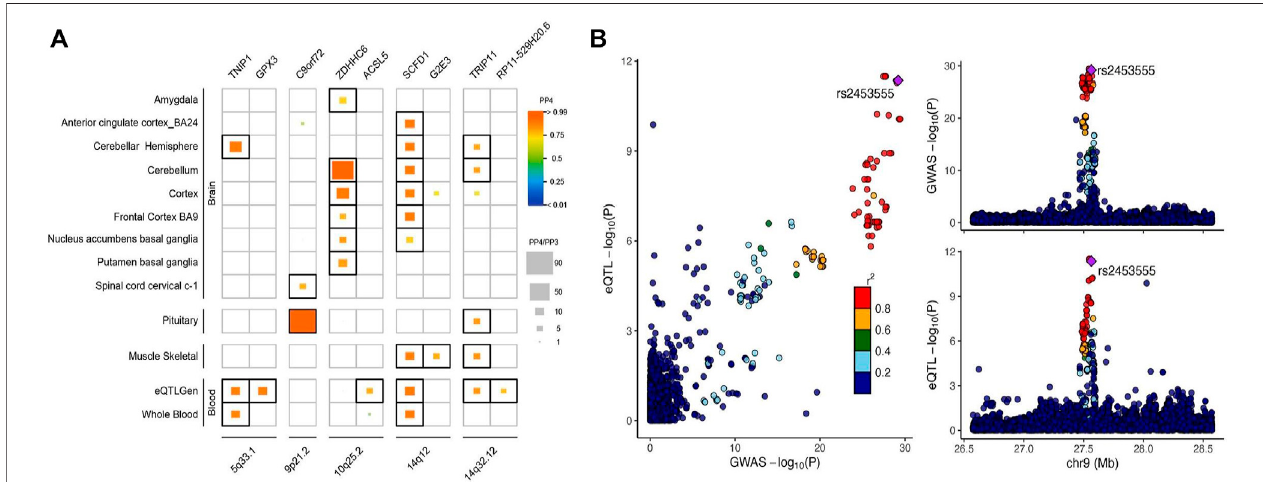
FIGURE 3 | Colocalization of genetic ALS association and eQTL in different tissues. (A) Heatmap of signi fi cant colocalization (PP4 ≥ 0.75, PP3 + PP4 ≥ 0.9, and PP4/PP3 ≥ 3)inatotalof16tissuesanalyzed.Thehorizontalaxisrepresentedgenesunderdifferentcytobands,andtheverticalaxisrepresenteddifferenttissues,where brain regions and the blood tissues were lined up together, respectively. The cell color indicated the posterior probability of colocalization with orange indicating larger values,and thesizeoftheinsidesquareswasproportionaltothePP4/PP3 ratio. (B) Illustration ofthe C9orf72 locusinthepituitary(PP4 ≥ 0.99, PP3+PP4 ≥ 0.99, and PP4/PP3 = 82.5). Each dot represented a genetic variant with the candidate causal variant, rs2453555, shown as a purple diamond. The color of other variants indicatedtheirlinkagedisequilibrium(r2)basedonthe1000GenomesProjectEuropeanreferencepanelwiththepurplediamondfrombluetored.Theleftpanelshowed − log10 p values for SNP associations with ALS on the x -axes, and − log10 p values for associations with gene expression levels on the y -axes. The right panel illustrated genomicpositions based on GRCh37 onthe x -axes and − log10 p values ofALSGWAS (upper panel) and − log10 p values ofgeneexpression at C9orf72 inthe pituitary gland (below panel) on the y